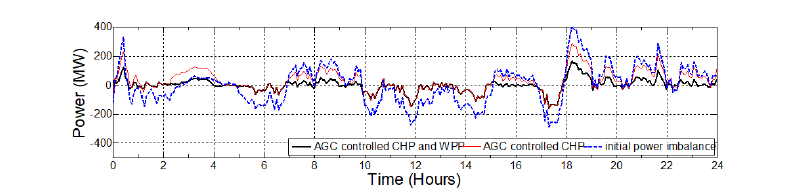
Figure 10. Comparison of power